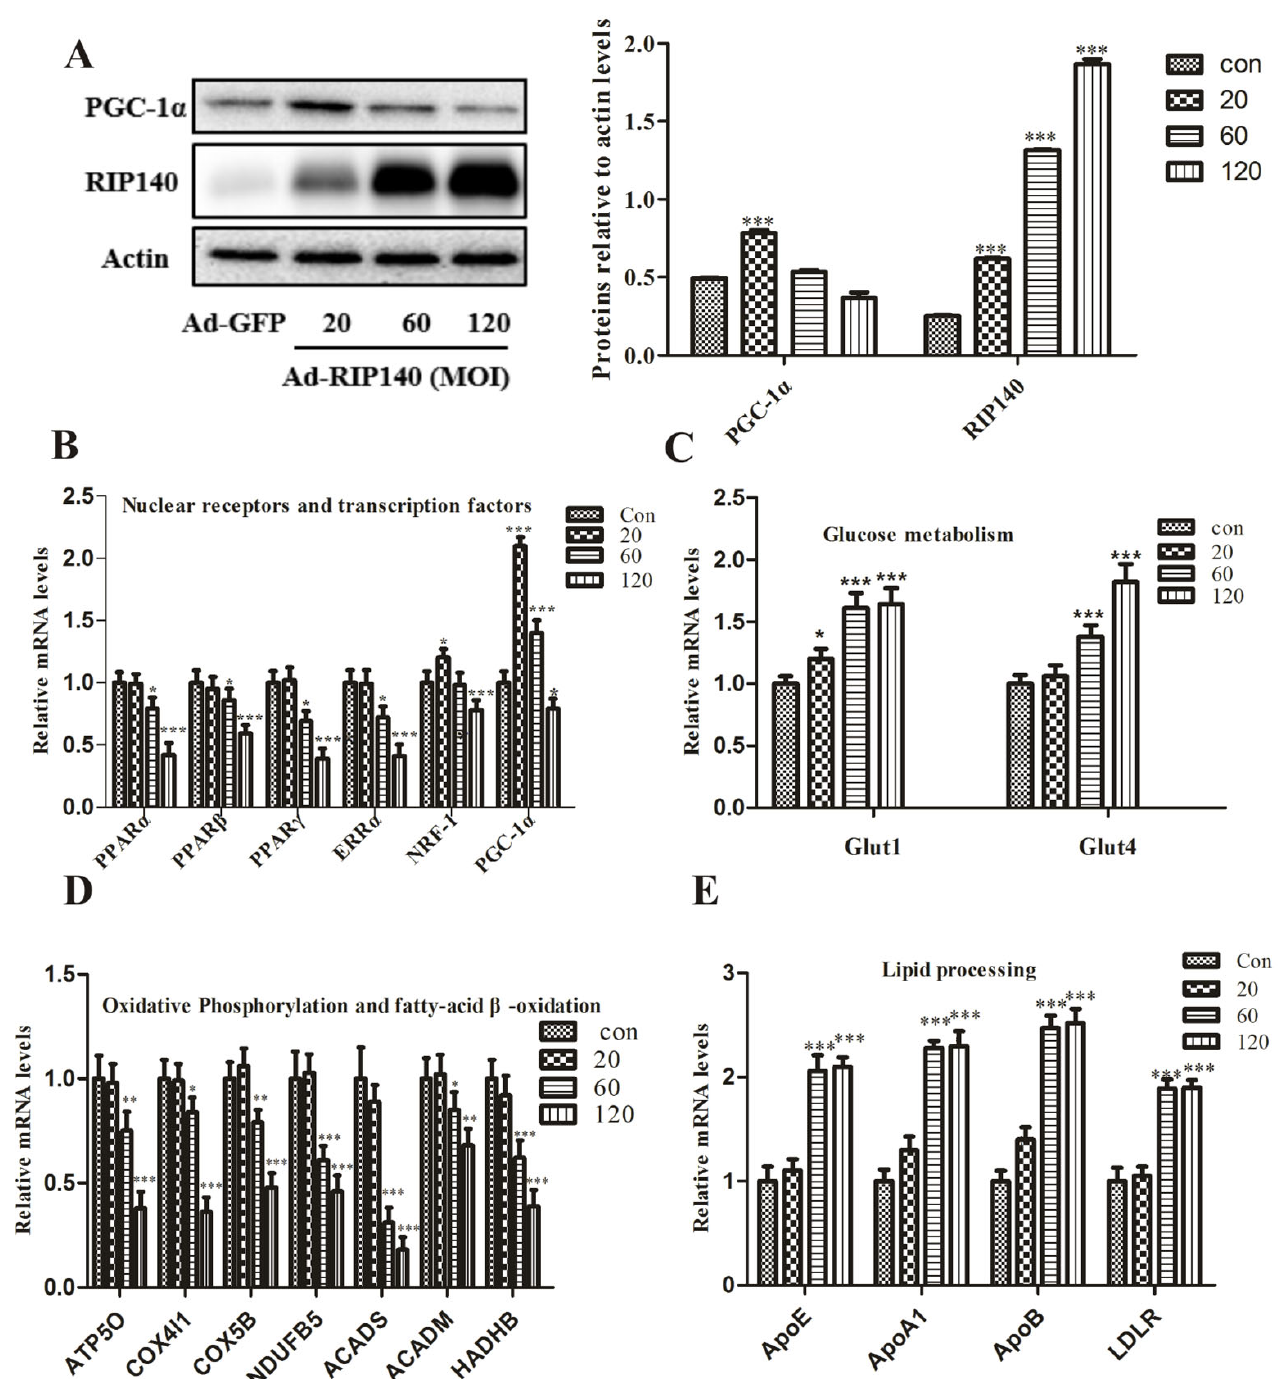
Figure 1. Key metabolic genes and lipid processing genes regulated by adenovirus-mediated over- expression of RIP140 in a dose-dependent manner. ( A ) RIP140 and PGC-1 α expression detected by Western blot analysis after Ad-RIP140 infection. ( B ) Results of real-time RT-PCR analysis for transcrip- tional regulators in RPE cells infected with Ad-RIP140 ( C , D ) Expression of metabolic genes associated with glucose and fatty acid metabolism at mRNA levels in the presence of different expression of RIP140. ( E ) Lipid processing genes altered in RIP140 groups. * p < 0.05, ** p < 0.01, *** p < 0.001 vs. Ad-GFP